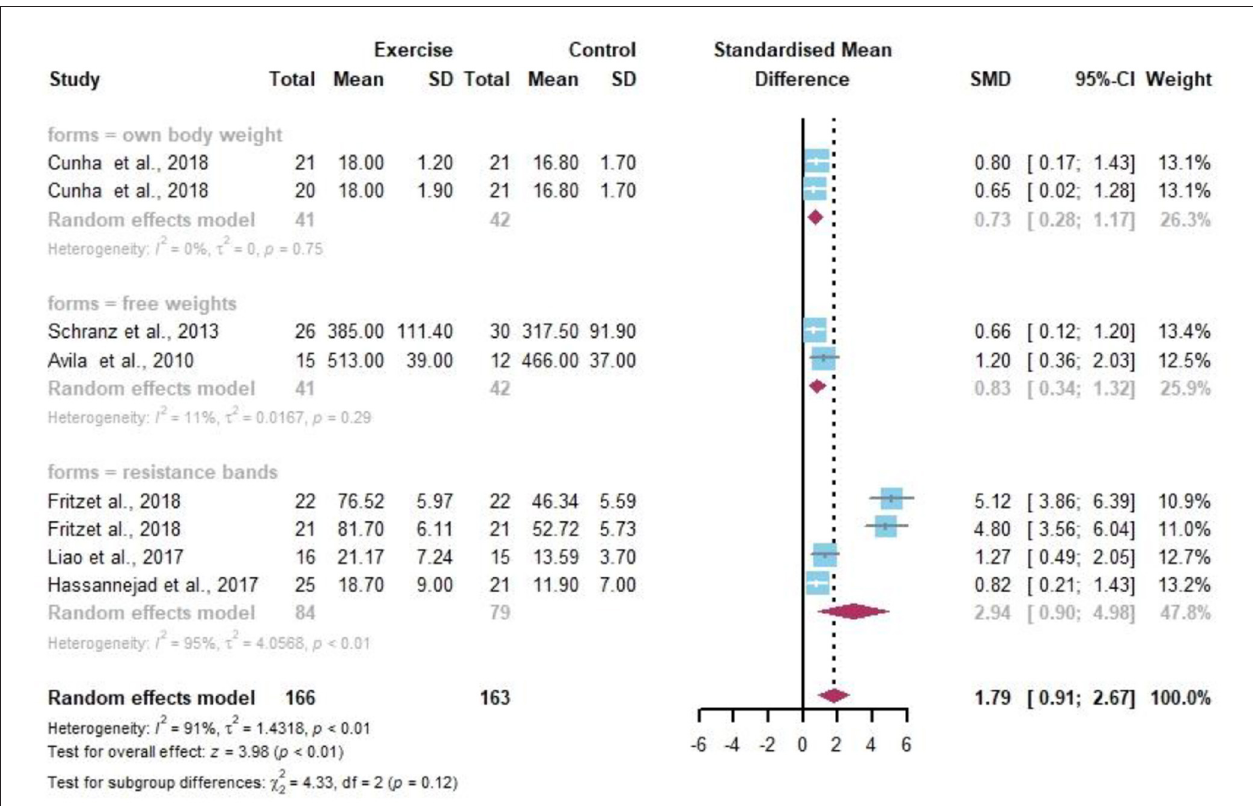
FIGURE 10 | Meta-analysis of effects of different resistance exercise forms on MS of overweight and/or obese